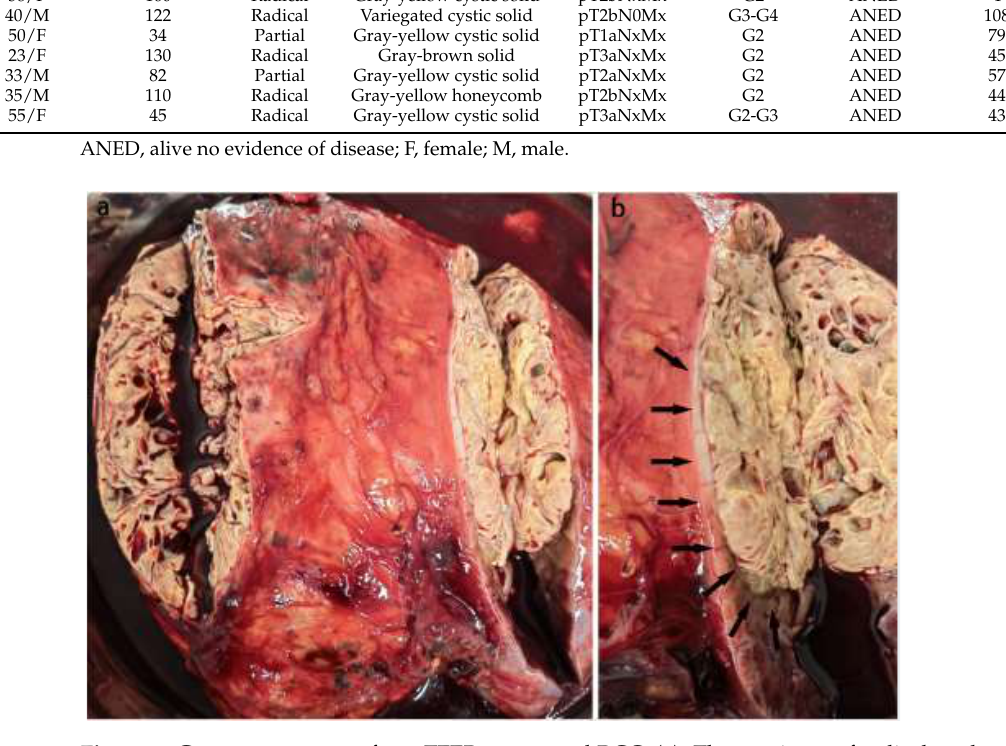
Figure 1. Gross appearance of one TFEB rearranged RCC. a. The specimen of radical nephrectomy showed a huge round tumor, cystic solid, tan-yellow soft, and slightly heterogeneous cut surface. b. The tumor was well-circumscribed and presented a partially dense fibrous pseudocapsule (ar- rowheads).